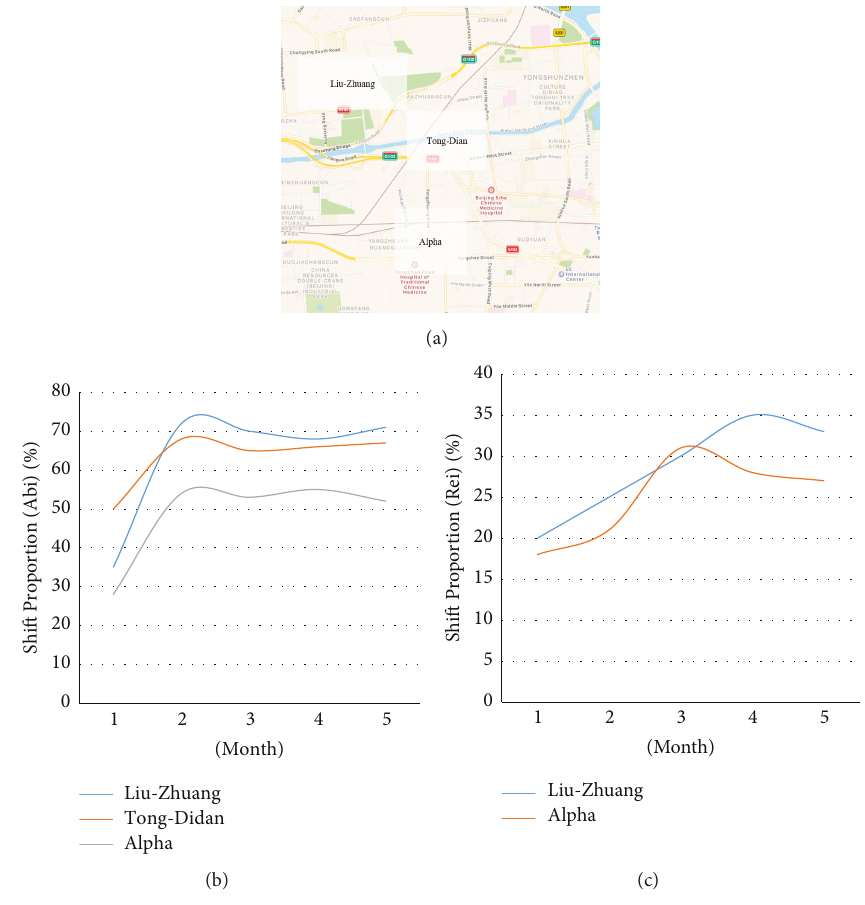
Figure 9: Research area and transition probability.